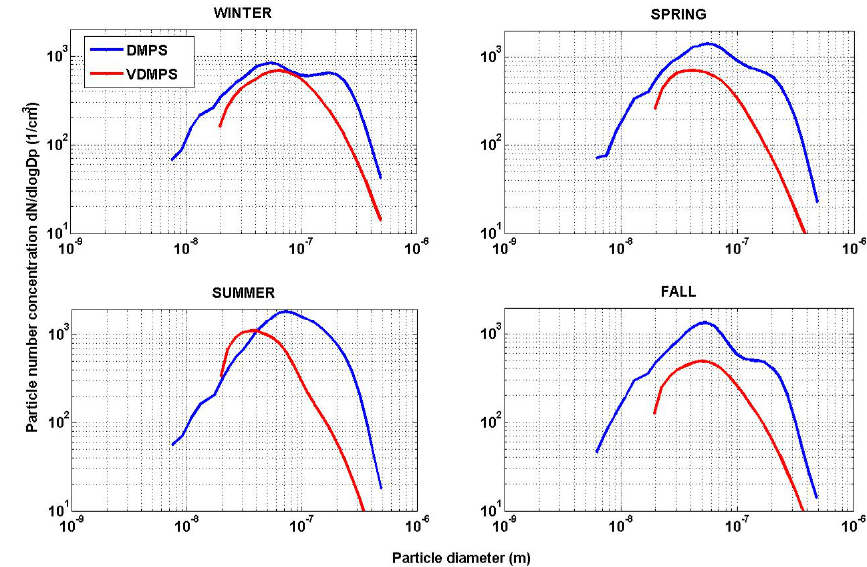
Fig. 3. Median particle number size distributions from DMPS and VDMPS at 280 ◦ C in different